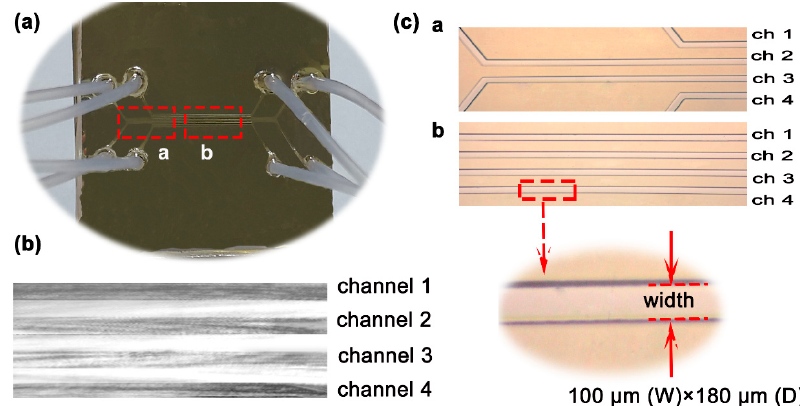
Figure 2. Sensor chip with integrated microchannels. ( a ) A polydimethylsiloxane (PDMS) slab with microchannels was bonded on the gold surface to form a closed microfluidic network (Channel: CH); ( b ) CCD image of the reflective light beam from the sensor chip; ( c ) Microscopic image of microchannels (a. the end of microchannel, b. the middle of microchannel).